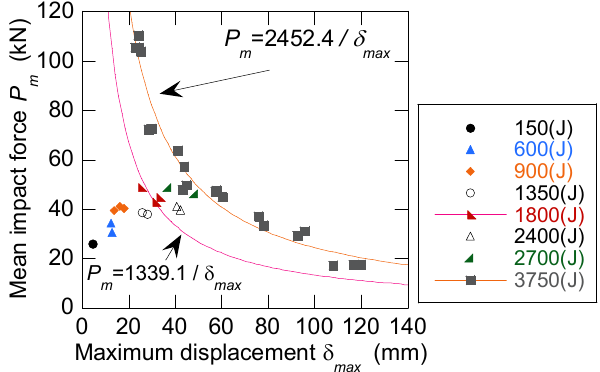
Fig. 10. Mean impact force and maximum displacement at midspan.